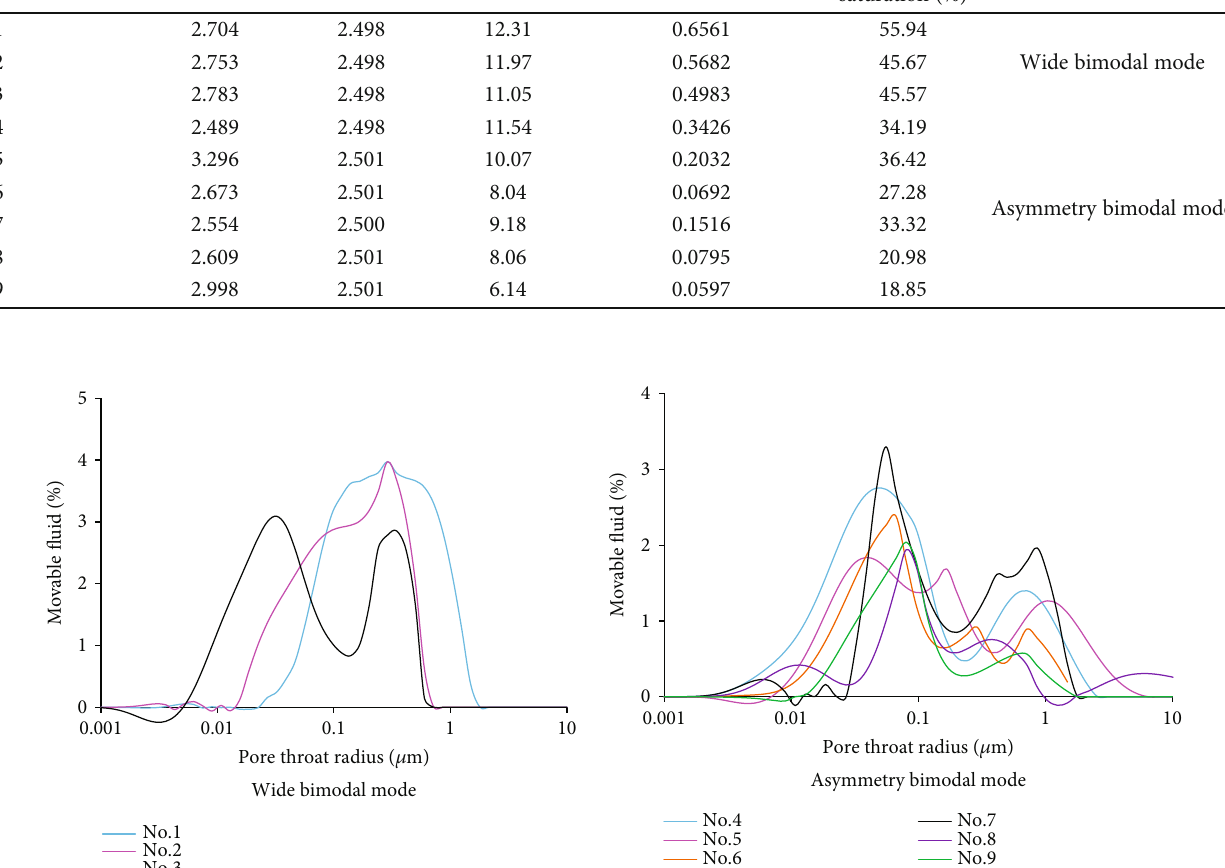
Figure 4: Movable fl uid distribution characteristics of reservoirs with di ff erent pore throat structure